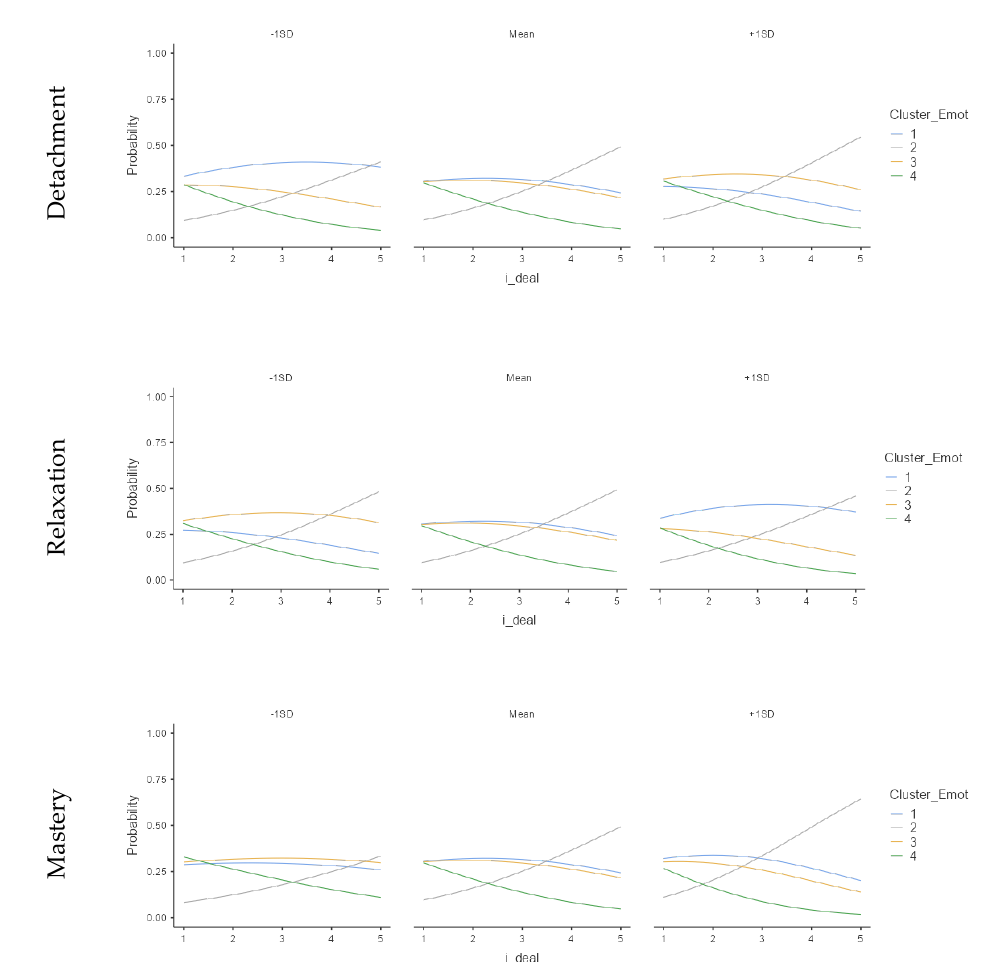
Figure 10. Recovery and Flexibility i-deal interaction related to Emotions and Job Performance clus- ters. Cluster 1: happy-productive; Cluster 2: Unhappy-productive; Cluster 3: Unhappy-unproductive; Cluster 4: happy-unproductive (Study 1; N = 386).